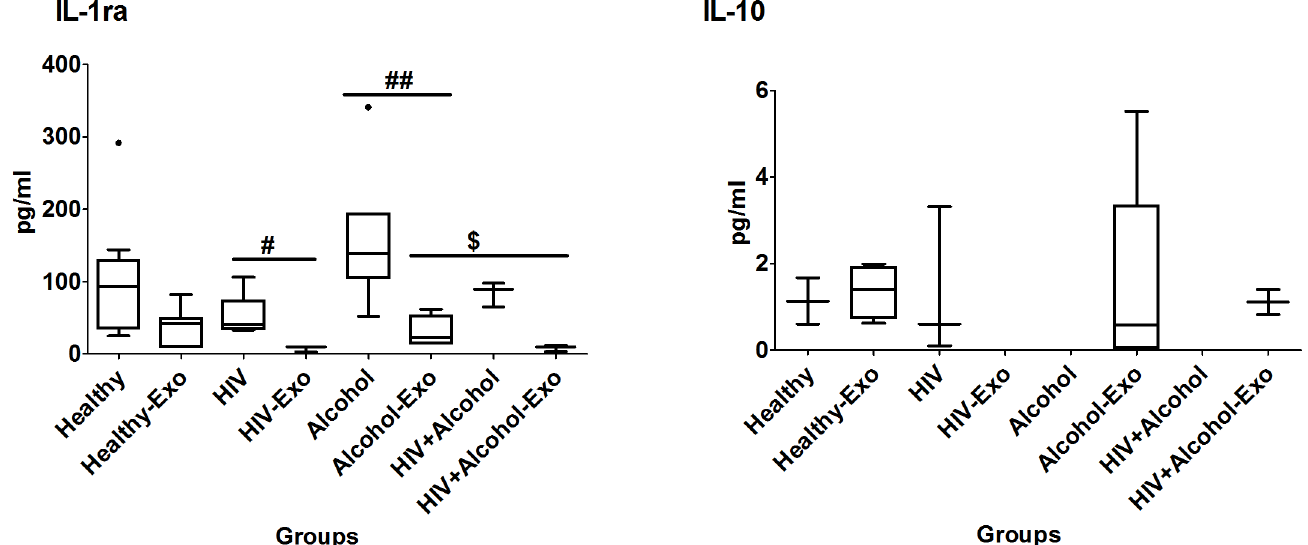
Fig 2. Box and whisker plots of anti-inflammatory cytokines between HIV-negative (healthy) non-drug abusers, HIV-positive non-drug abusers (HIV), HIV-negative alcohol drinkers (alcohol) and HIV-positive alcohol drinkers (HIV+alcohol). The box represents the 25 th -75 th quartile, the whiskers represent the range of values, the median is presented as a line inside the box, and the out-of-range values are presented as circles. The Mann–Whitney U test was used to compare between plasma and exosomes of different study groups, and significant p-values are represented as # (p (cid:20) 0.05), and ## (p (cid:20) 0.01). Comparison of cytokine levels among plasma as well as exosomes of different groups were done using Mann–Whitney U test and significant p-values are given as (cid:3) (p (cid:20) 0.05), (cid:3)(cid:3) (p (cid:20) 0.01) and $ (p (cid:20) 0.05), $ $(p (cid:20) 0.01), respectively.